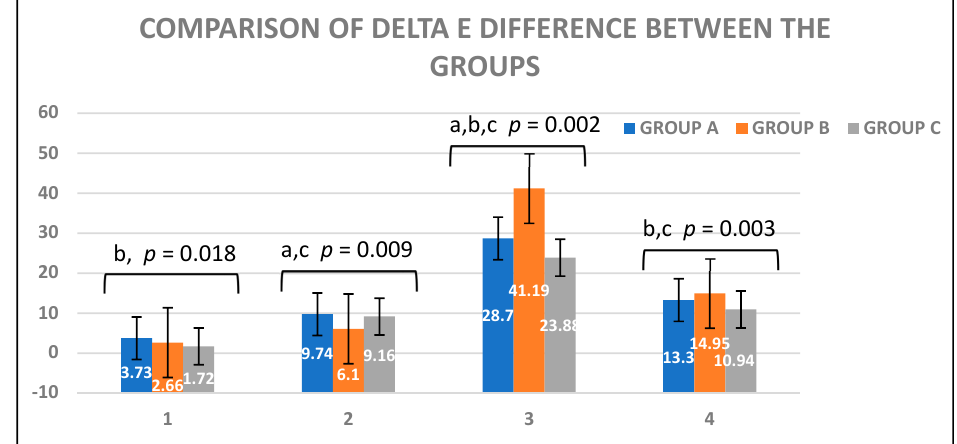
Scheme 6. Comparison of ∆ E difference between the groups. a- difference between A and B, b- difference between A and C, c- difference between B and